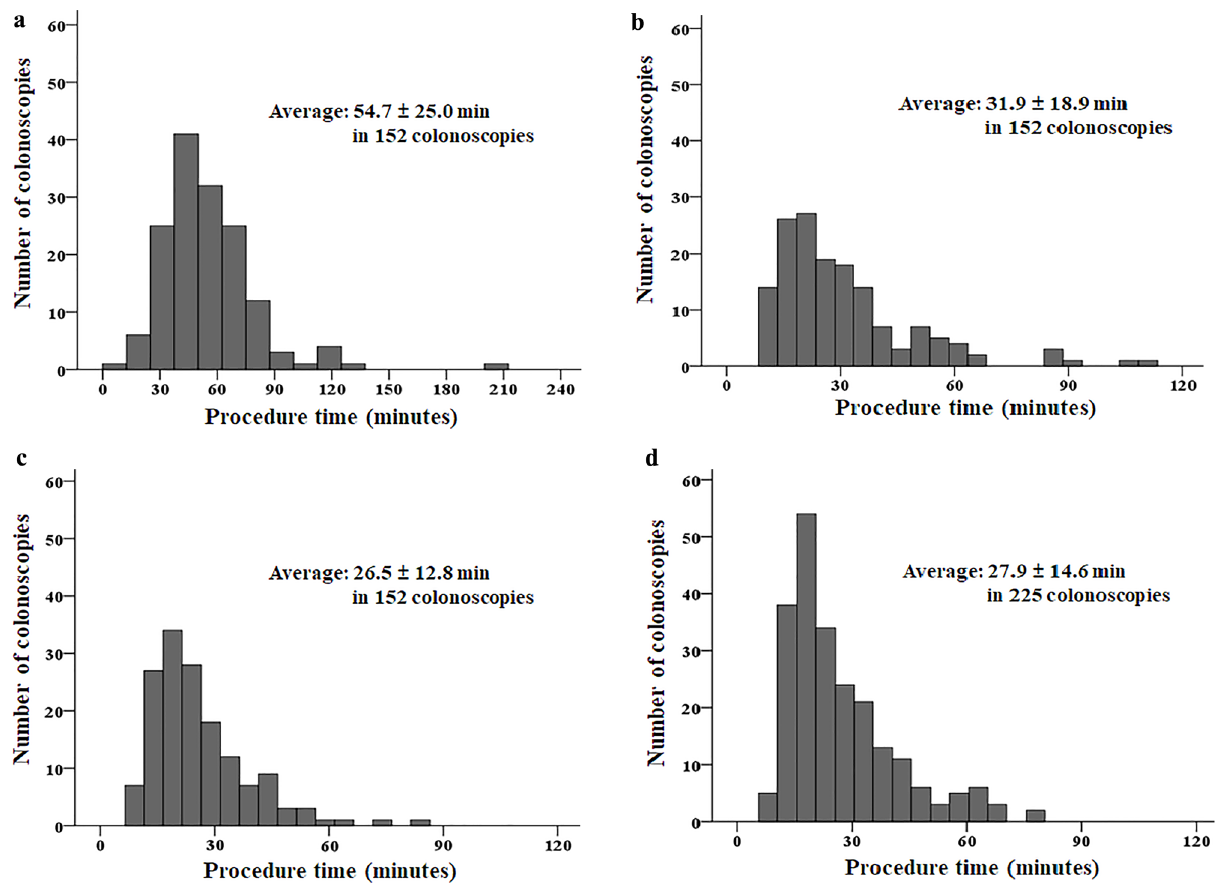
Figure 1. Colonoscopy procedure time ( a ) baseline colonoscopies, ( b ) first surveillance colonoscopies, ( c ) second surveillance colonoscopies, and ( d ) third and subsequent surveillance